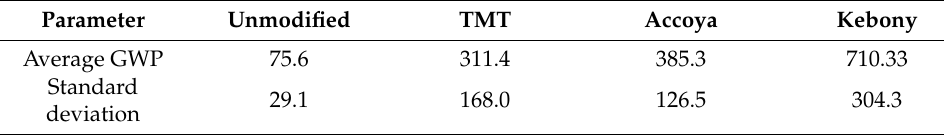
Table 4. Average values of GWP impact used for the